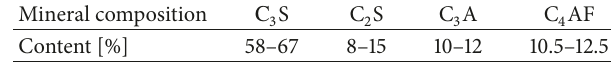
The predominant type of coal